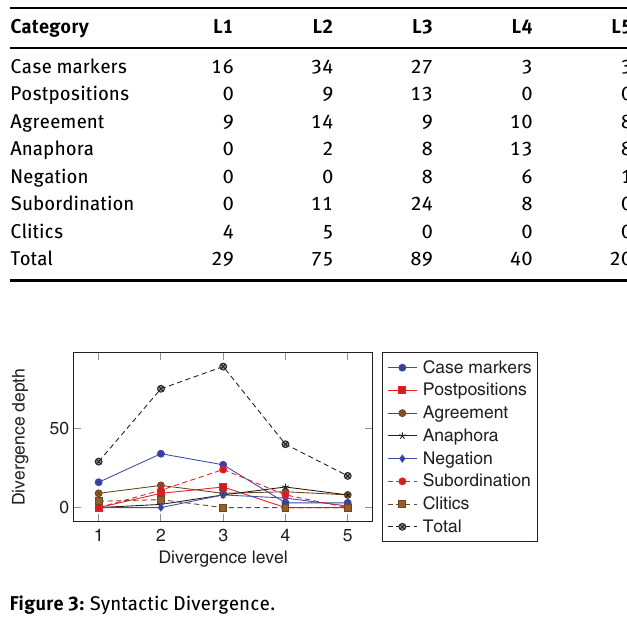
Figure 2: Morphological Divergence. Table 6: Syntactic DI Quantification.